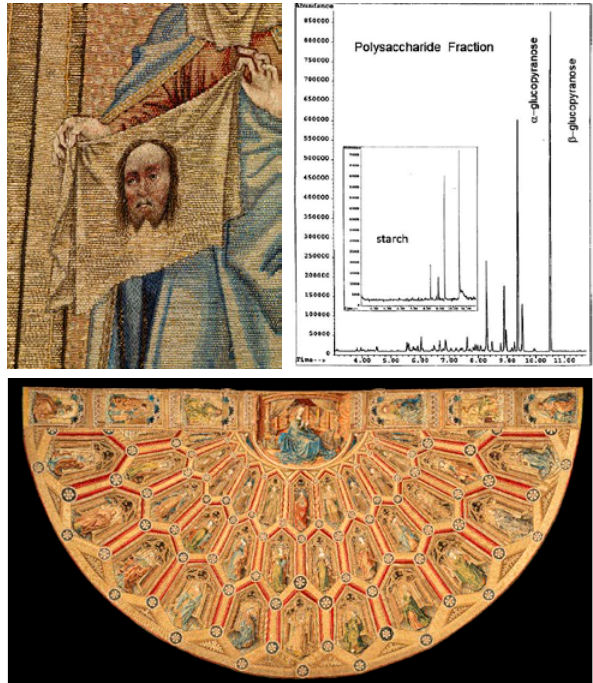
Figure 13. GC-MS of the polysaccharide fraction from a sample of the Cope of the Virgin Mary (15 th century). The Cope measures 330 cm in width and 164 cm in length. Peaks: α- and β-glucopyranose. (TMS derivatives after hydrolysis and concomitant group-separa- tion by an ion exchanger from the proteinaceous fractions). Insert: GC-MS of barley starch; same procedure as the for sample of the Cope. Time in min. Peaks recorded from TIC. For details see text, Supplementary information and ref. [102] . From ref. [102] with per- mission. Bottom and left picture: Long shot and detail of the Cope of the Virgin Mary . Photographic images by courtesy of KHM-Muse- umsverband, Vienna,